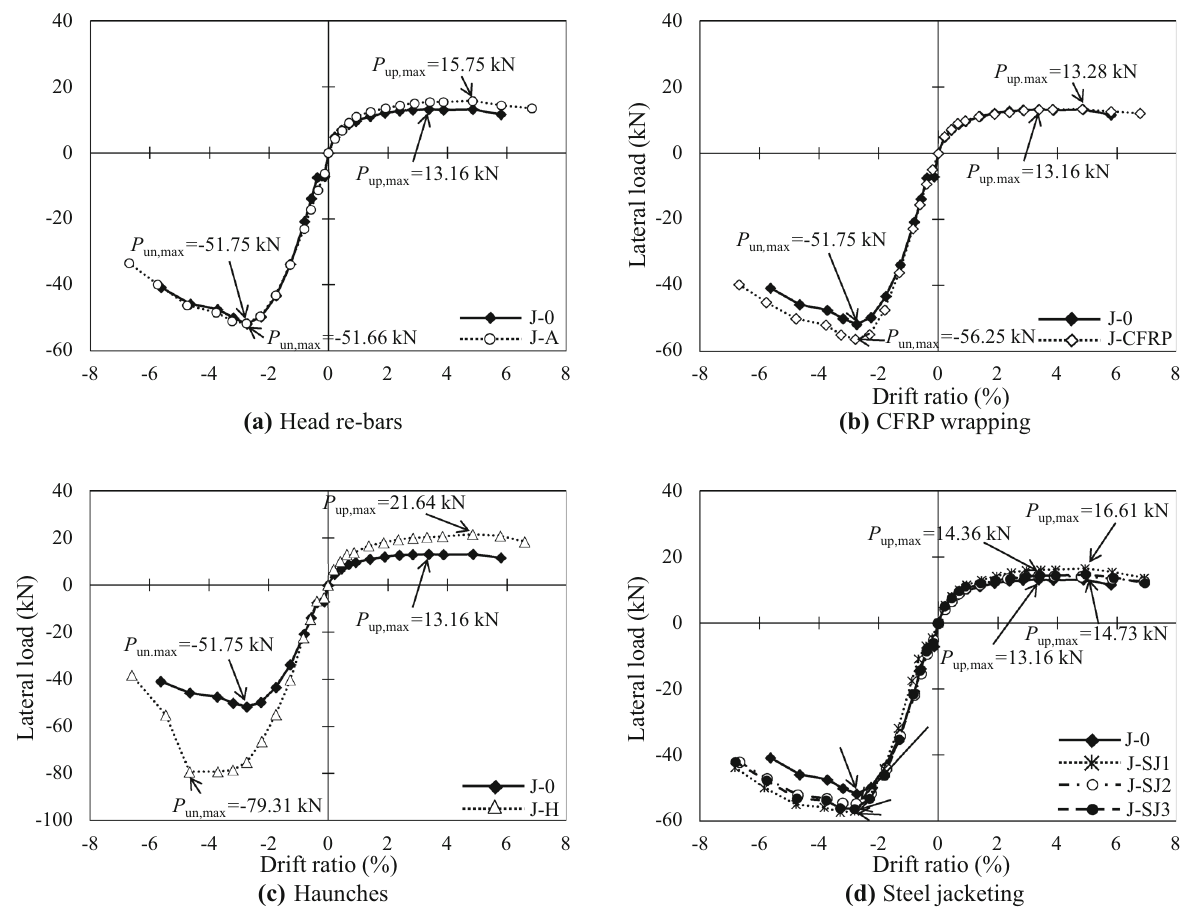
Fig. 16 Effects of various retrofit applications on load–drift relationships: a head re-bars, b CFRP wrapping, c haunches, and d steel jacketing.